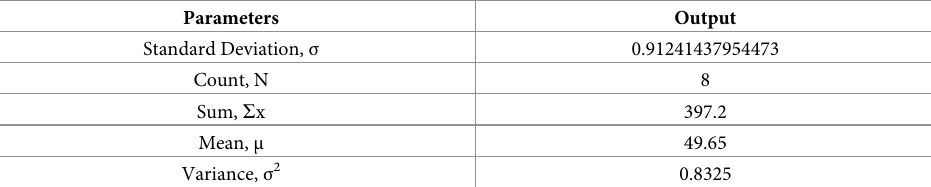
Table 4. Statistical metrics for function g(X) distribution.